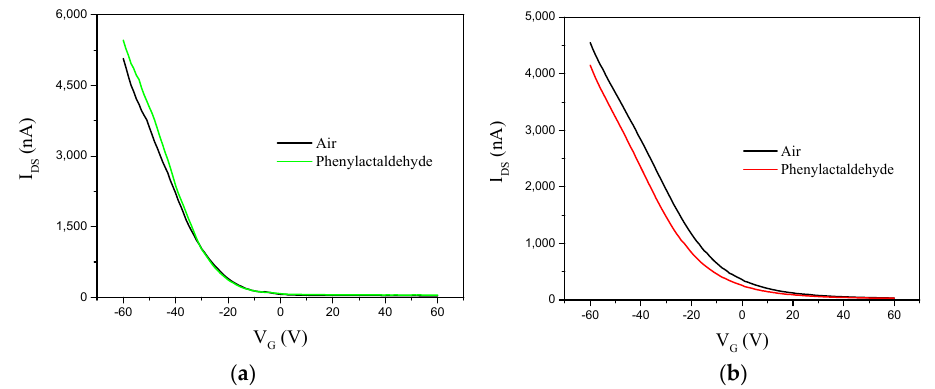
Figure 9. Transfer characteristic ( I DS –V G curves at V DS = 0.1 V) of ( a ) s1DNA-SWNT and ( b ) s2DNA- SWNT devices in presence of air and saturated